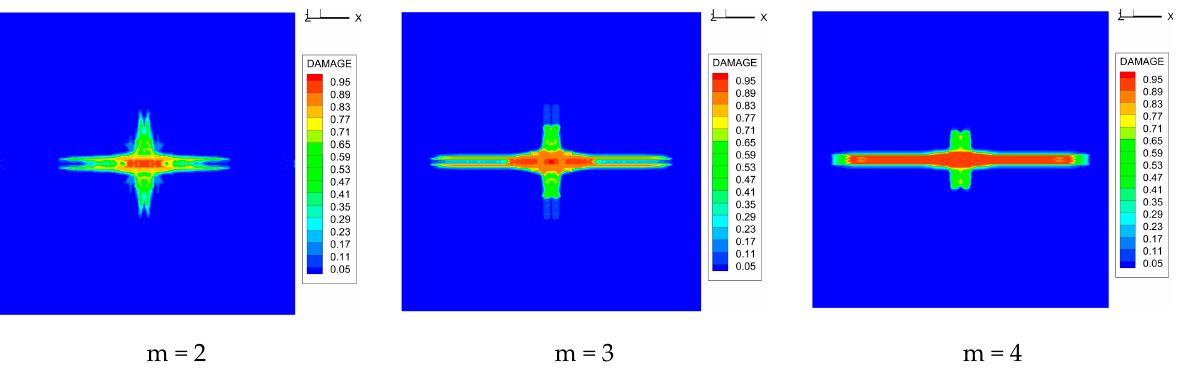
Figure 10. Damage pattern of composite laminate (front surface).